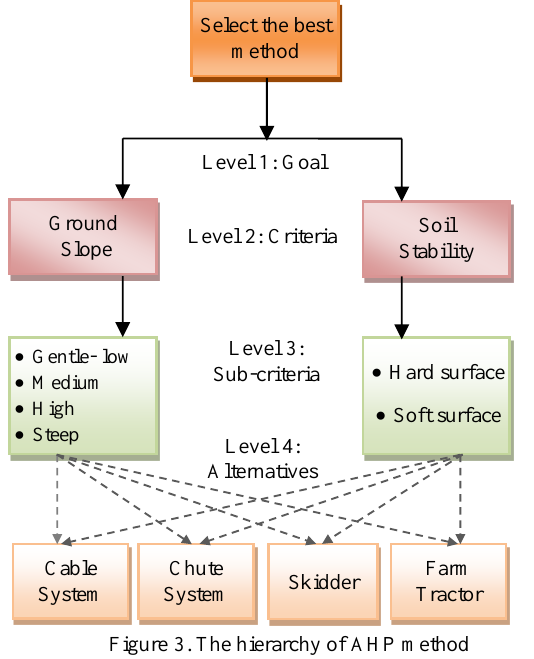
Figure 3. The hierarchy of AHP method